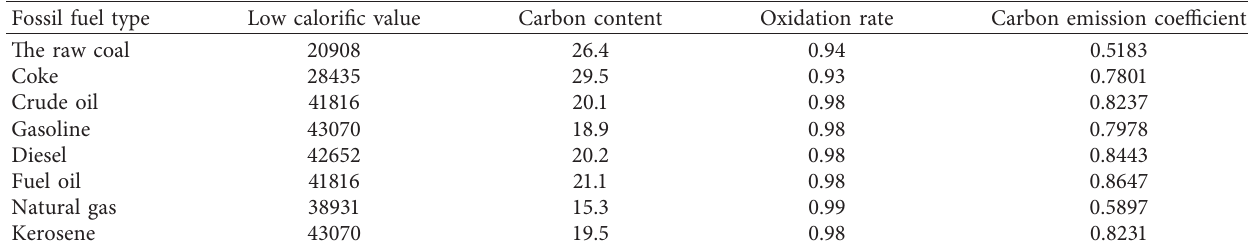
Table 1: The carbon emission coefficients for each type of fossil